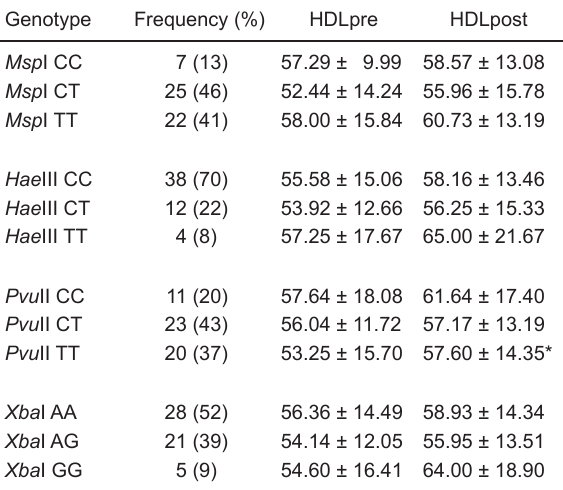
Table 1. Genotype frequencies and high-density lipoprotein lev- els before (HDLpre) and after (HDLpost) hormone replacement therapy in each estrogen receptor-alpha